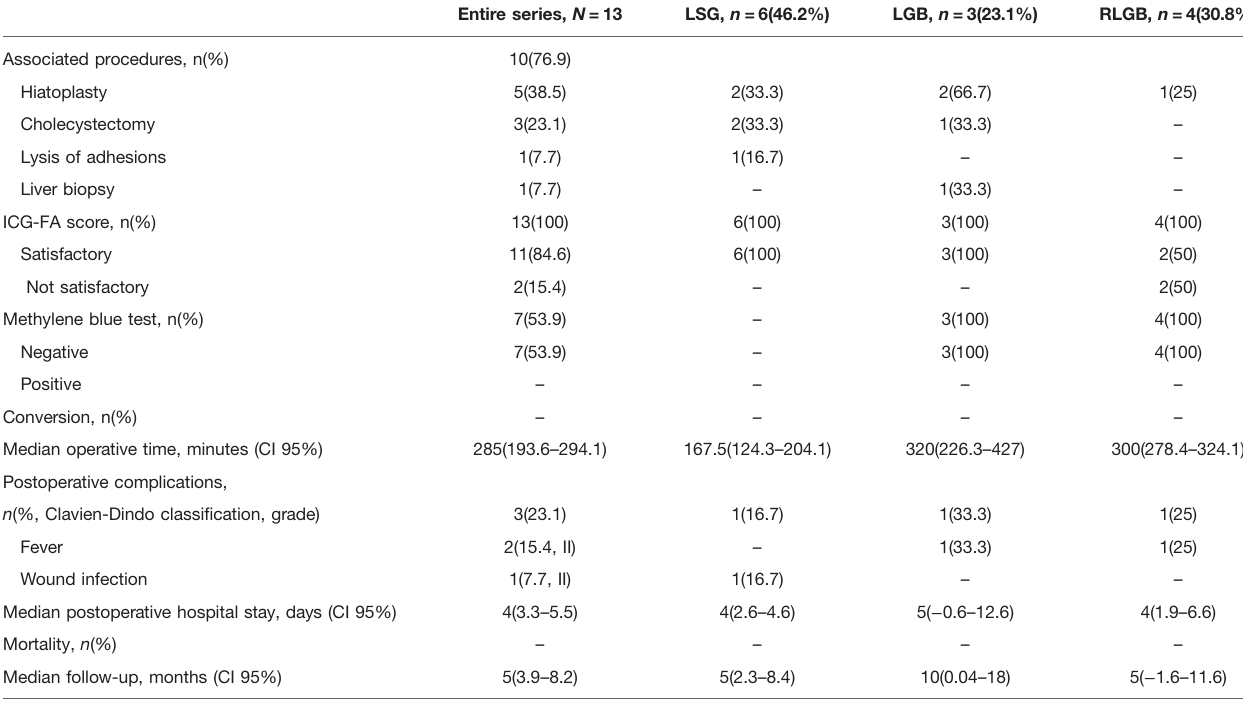
TABLE 2 | Surgical